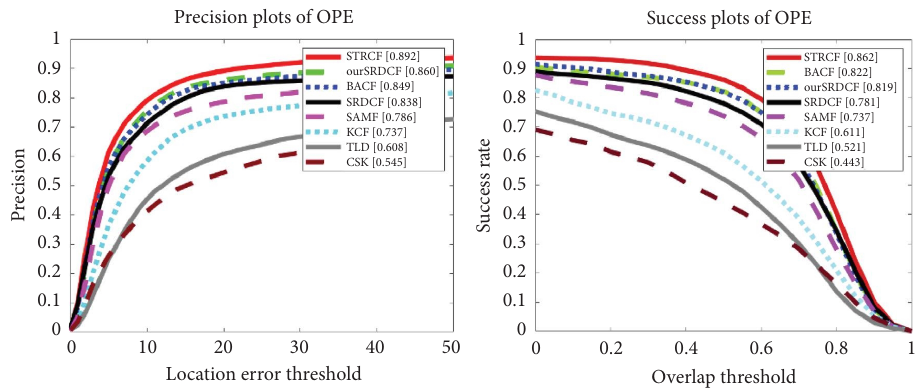
Figure 4: Overall performance evaluation results of several